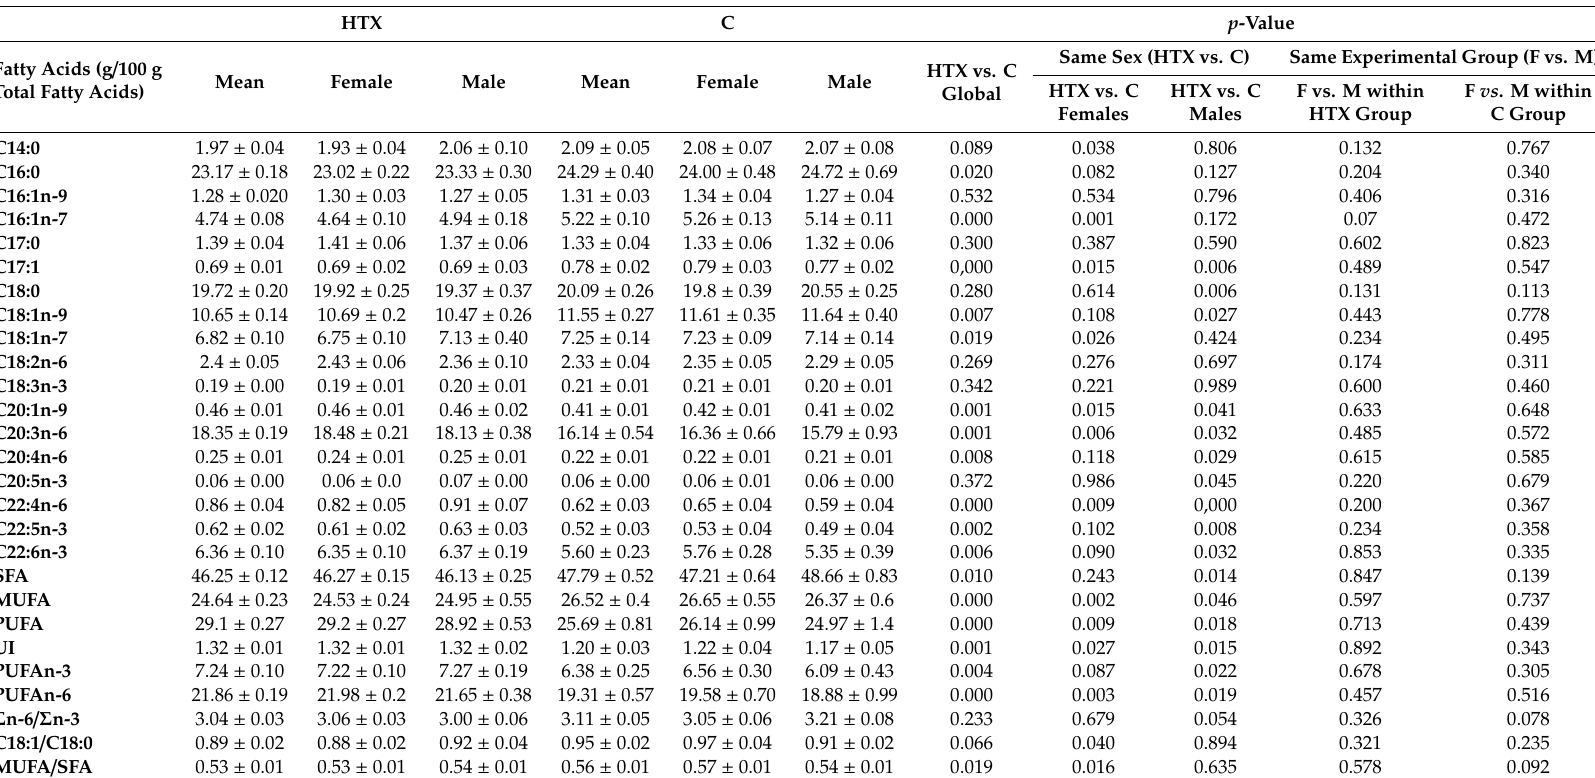
Table 3. E ff ects and di ff erences between sexes, of maternal hydroxytyrosol supplementation on the fatty acid profile of the fetal liver. Mean values ( ± SEM) of polar lipids in female (F) and male (M) fetuses of the treated (HTX) and the control group (C). HTX C p -Value Fatty Acids (g / 100 g Mean Female Male Mean Female Male Total Fatty Acids)